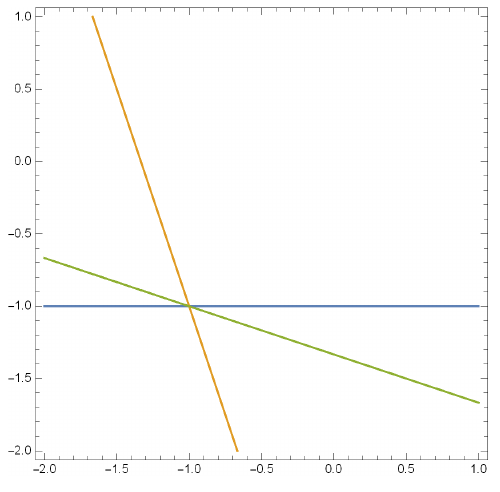
Figure 5. Regions delimited by D ( γ , θ ) =